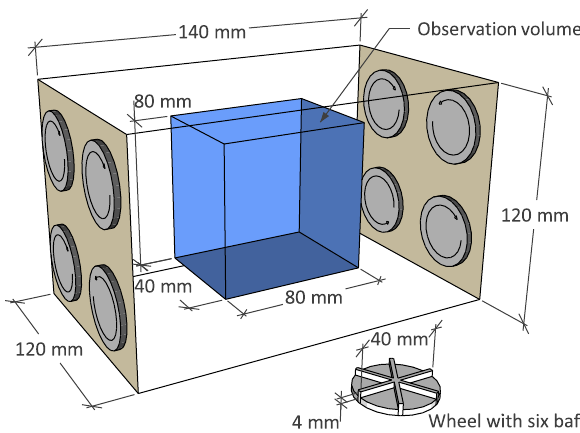
FIG. 6. Schematic representation of the experimental setup: overview of the aquarium with turbulence generator and obser- vation volume and enlargement of one of the actuated